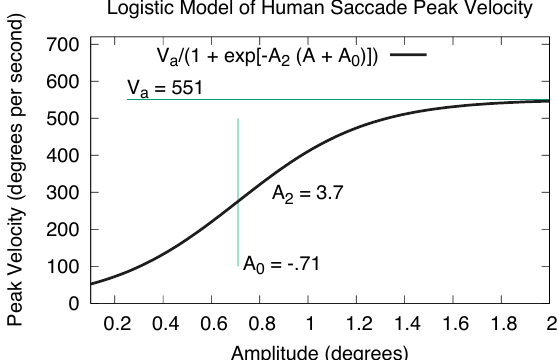
Figure 2 . Interpretation of logistic function